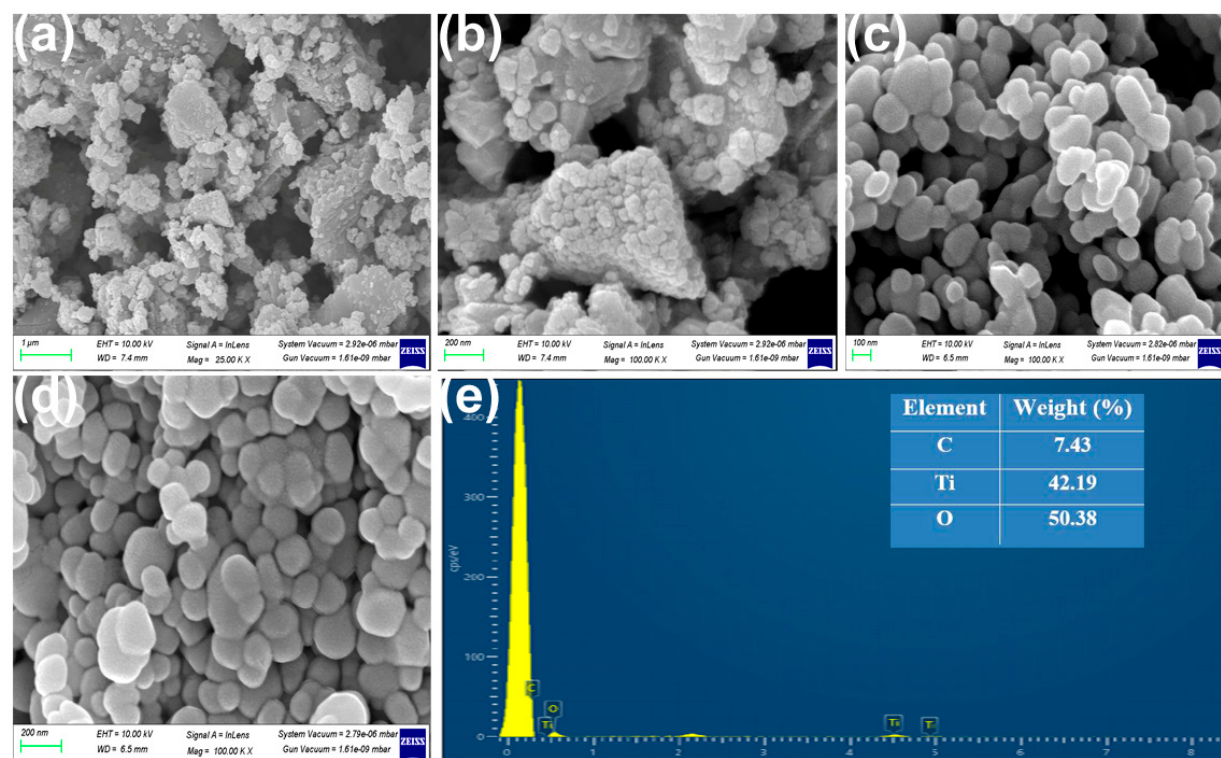
Figure 4. SEM images ( a , b ) of TiO 2 , AC/TiO 2 nanoparticles ( c , d ) and EDX spectrum ( e ) of AC/TiO 2 nanoparticles.